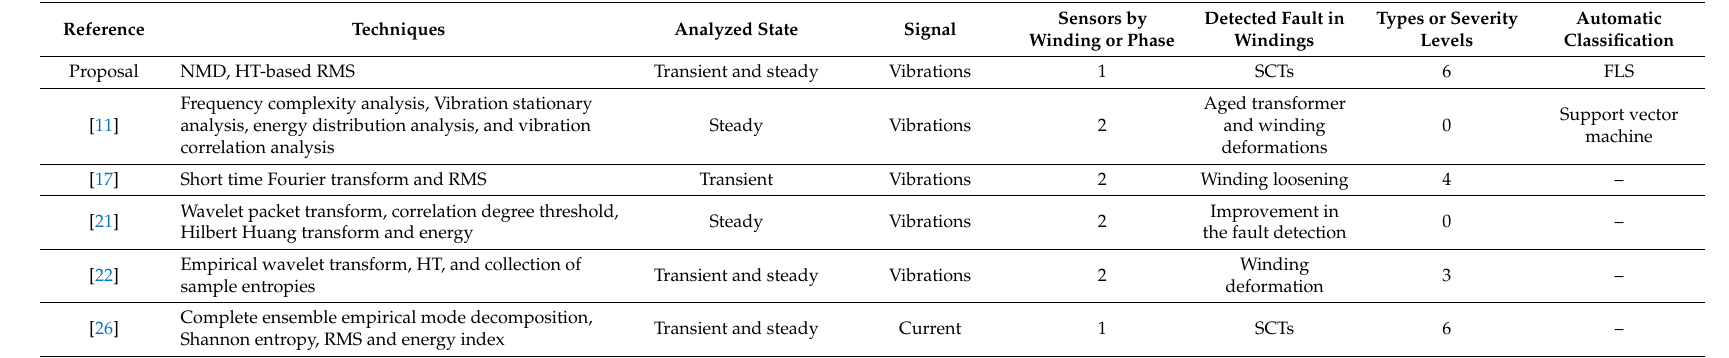
Table 4. Comparation of the proposed methodology against other relevant